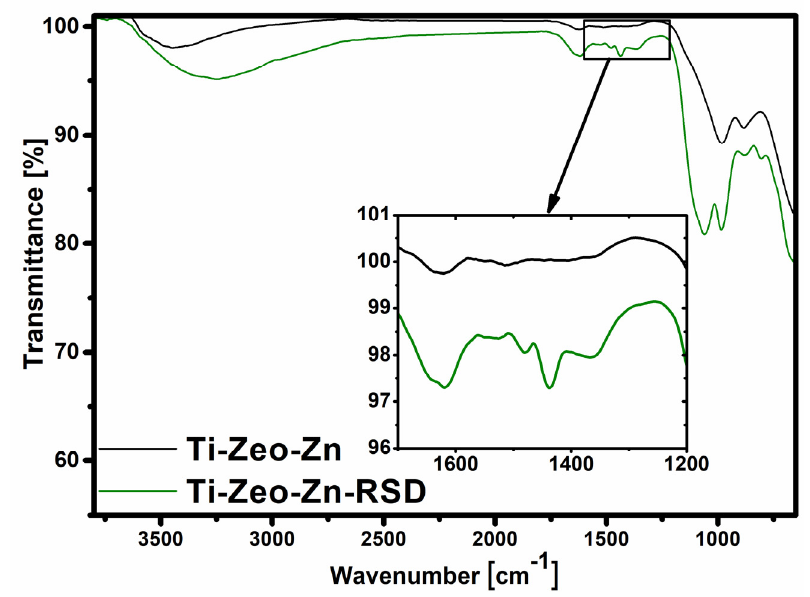
Figure 5. FTIR spectra of zinc zeolite layers before and after drug sorption.